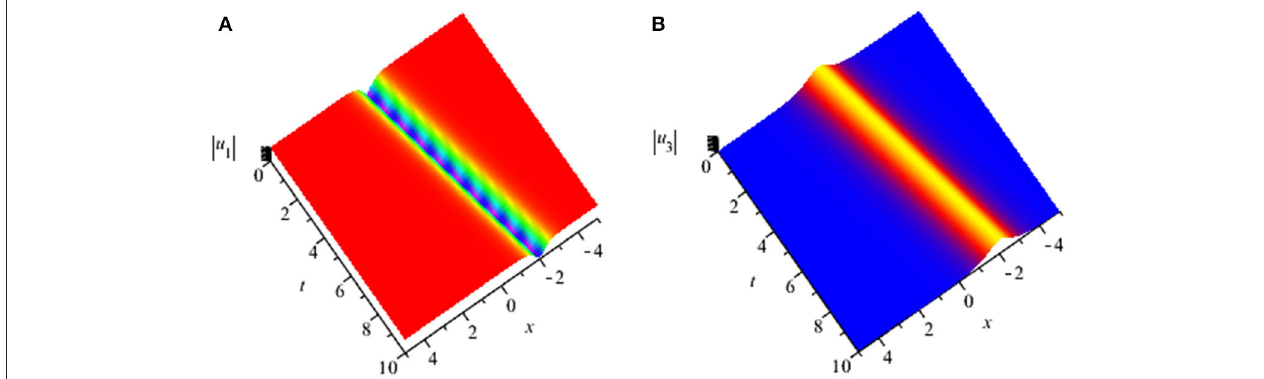
FIGURE 1 | (A) The 3-dimensional graph of | u 1 ( x , t ) | for α 1 = 1, α 2 = 1, α 3 = 1, α 4 = 1, κ = 0.1, and θ = 0; (B) The 3-dimensional graph of | u 3 ( x , t ) | for α 1 = 1, α 2 = 1, α 3 = 1, α 4 = 1, κ = 0.1, and θ = 0.